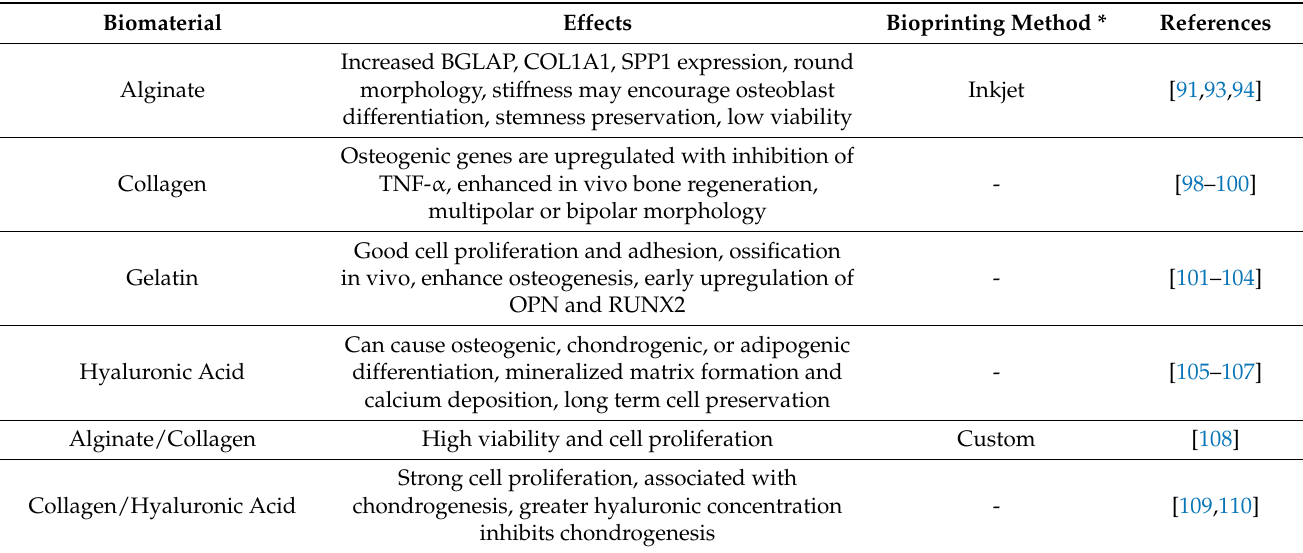
Table 3. Adipose stem cells in